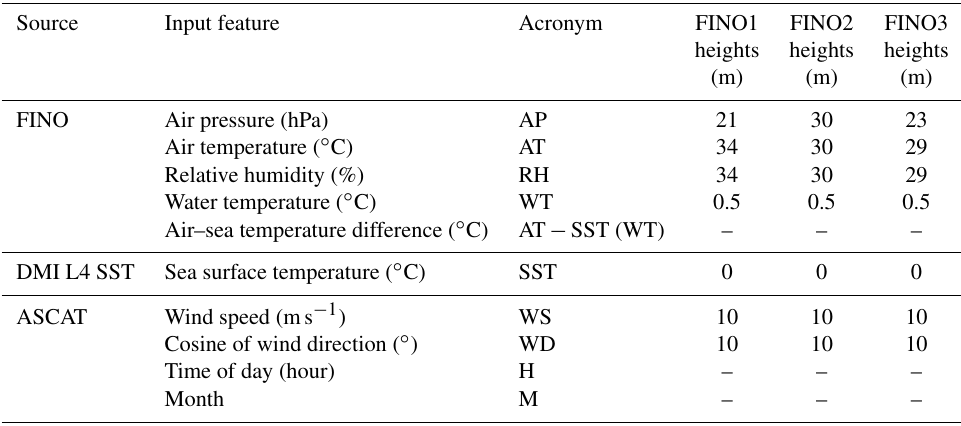
Table 2. Input features and heights used to train the random forest model at the FINO met masts. All of the data measured from the FINO masts are 30min averaged.